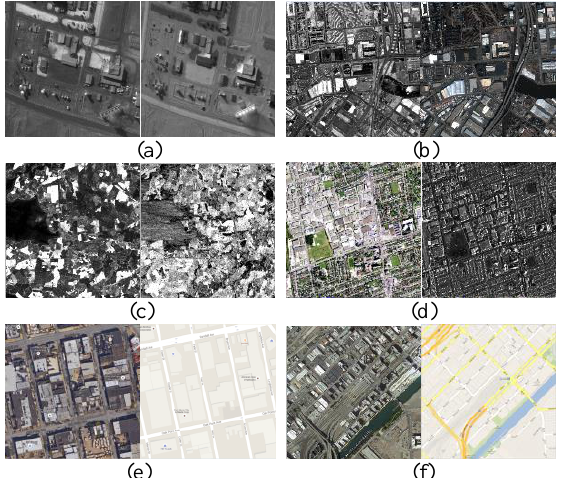
Figure 3 Multimodal remote sensing images. (a) Test 1. (b)